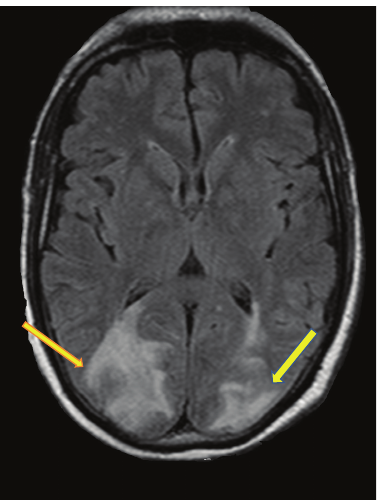
Figure 1: Increased T2 uptake sequence on cerebral occipital parietal